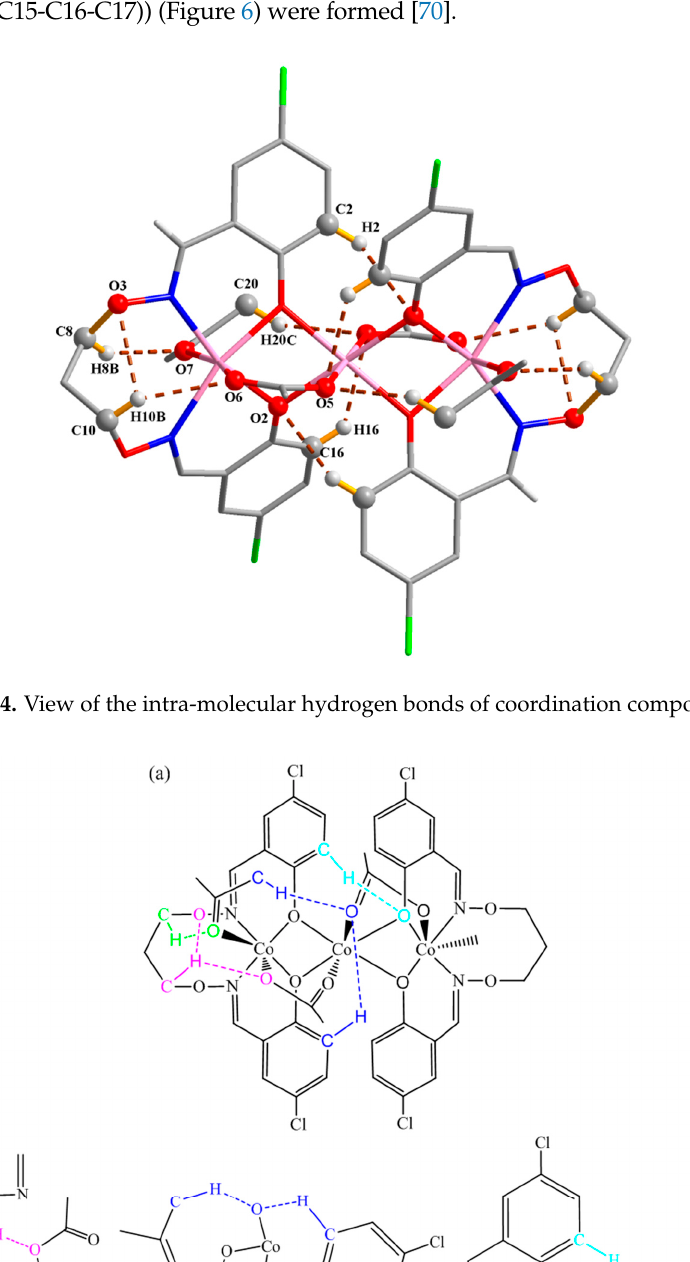
Figure 3. ( a ) Molecular structure and atom numberings of coordination compound 1 with 30% probability displacement ellipsoids (hydrogen atoms are omitted for clarity); ( b ) Coordination polyhedra for Co(II) atoms of coordination compound 1 .